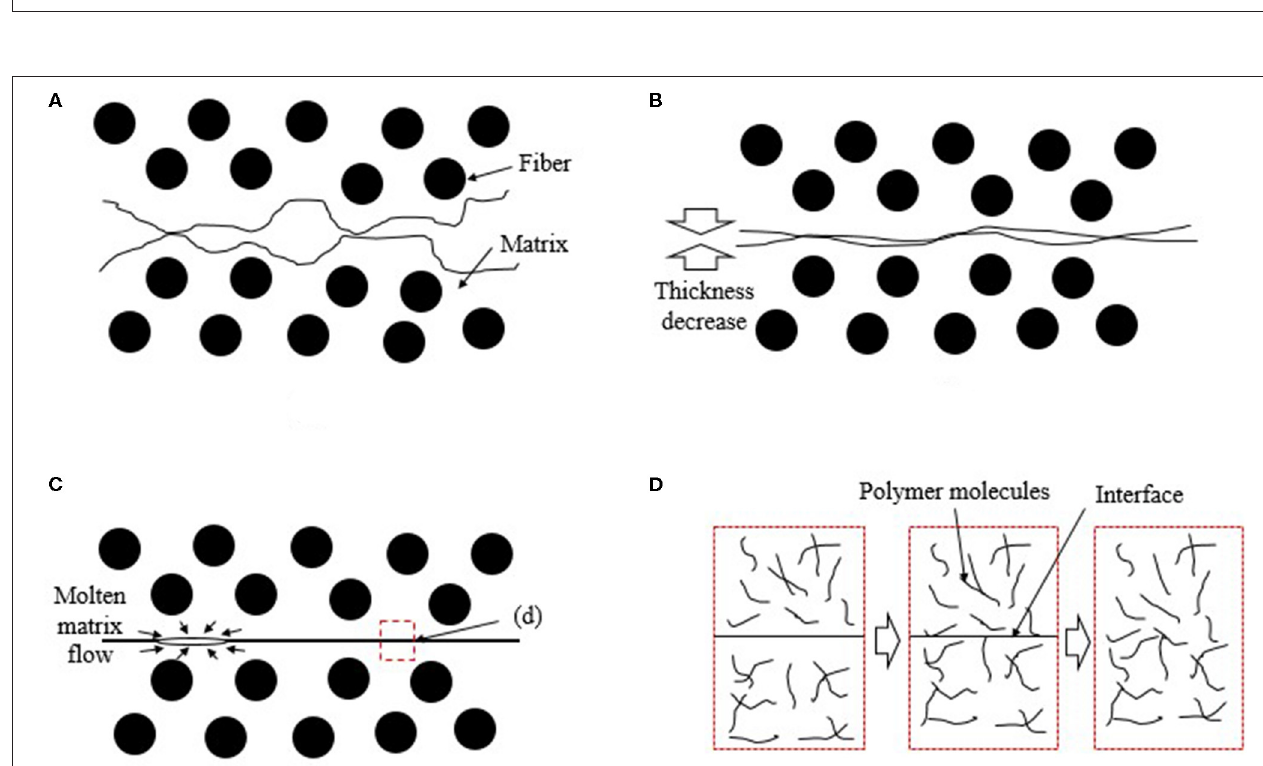
FIGURE 8 | Schematic of the interlaminar consolidation phenomena. (A) Below T g . (B) At T g (Establishment of intimate contact). (C) At T m (Molten matrix flow). (D) Above T m (Interdiffusion of polymer